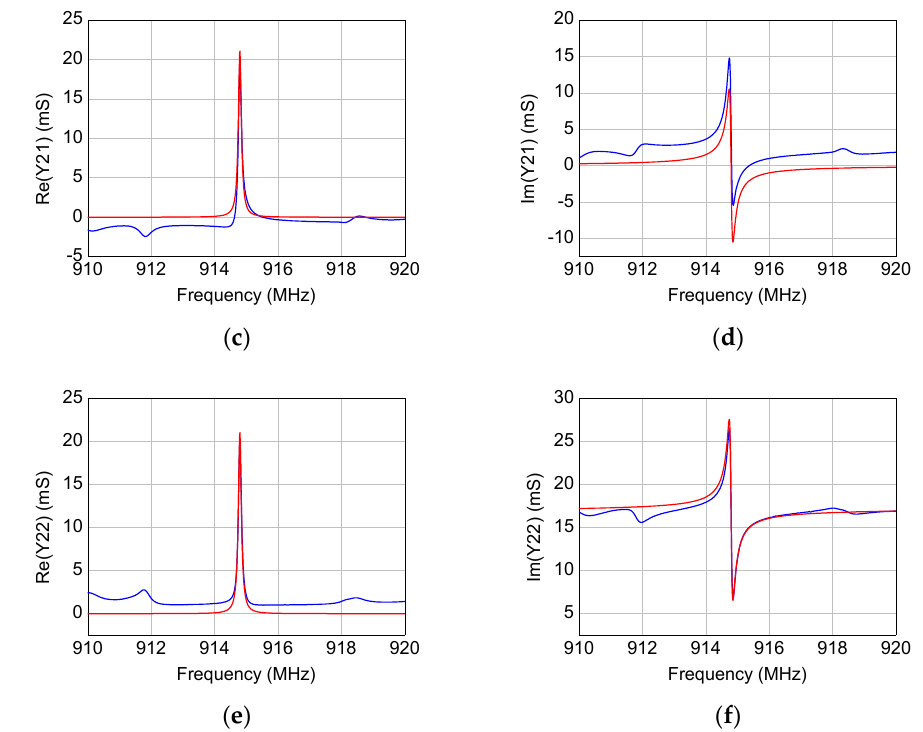
Figure 9. Comparison between (blue) measured and (red) simulated frequency-dependent behavior of ( a , b ) Y 11 , ( c , d ) Y 21 , and ( e , f ) Y 22 for the 915 MHz SAW resonator.